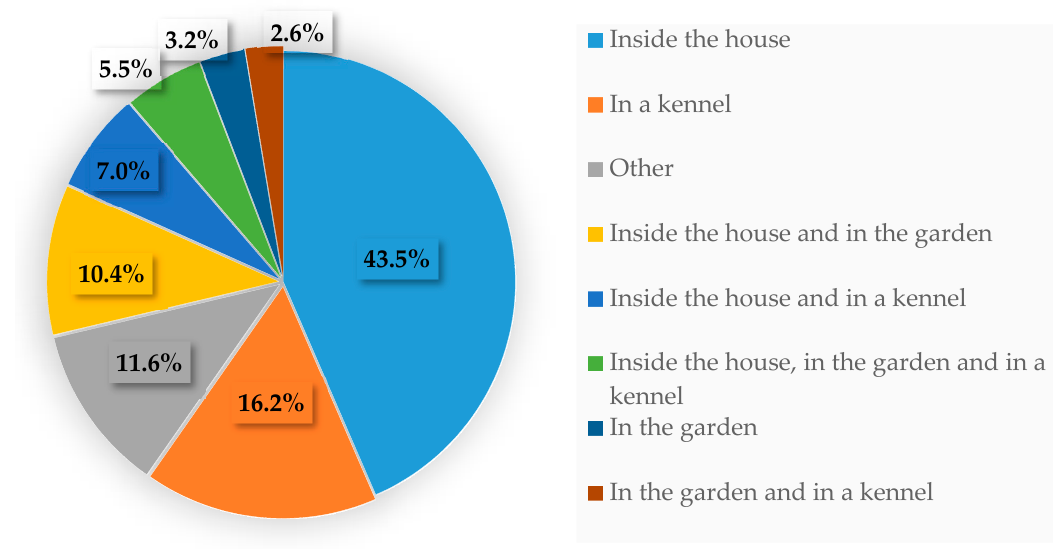
Figure 2. Housing systems of the breeding bitches when not in peripartum (multiple answers allowed).